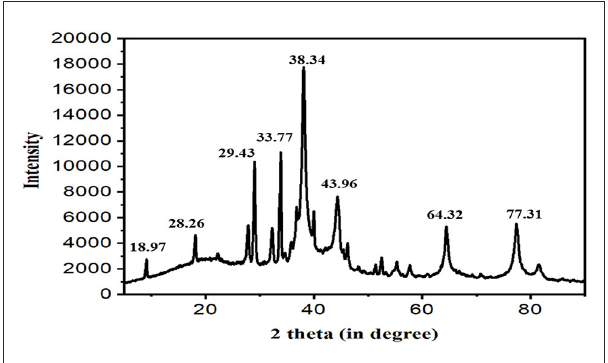
FIGURE4 X-ray diffraction (XRD) patterns of the synthesized Ag NPs from MFCF of T. harzianum .